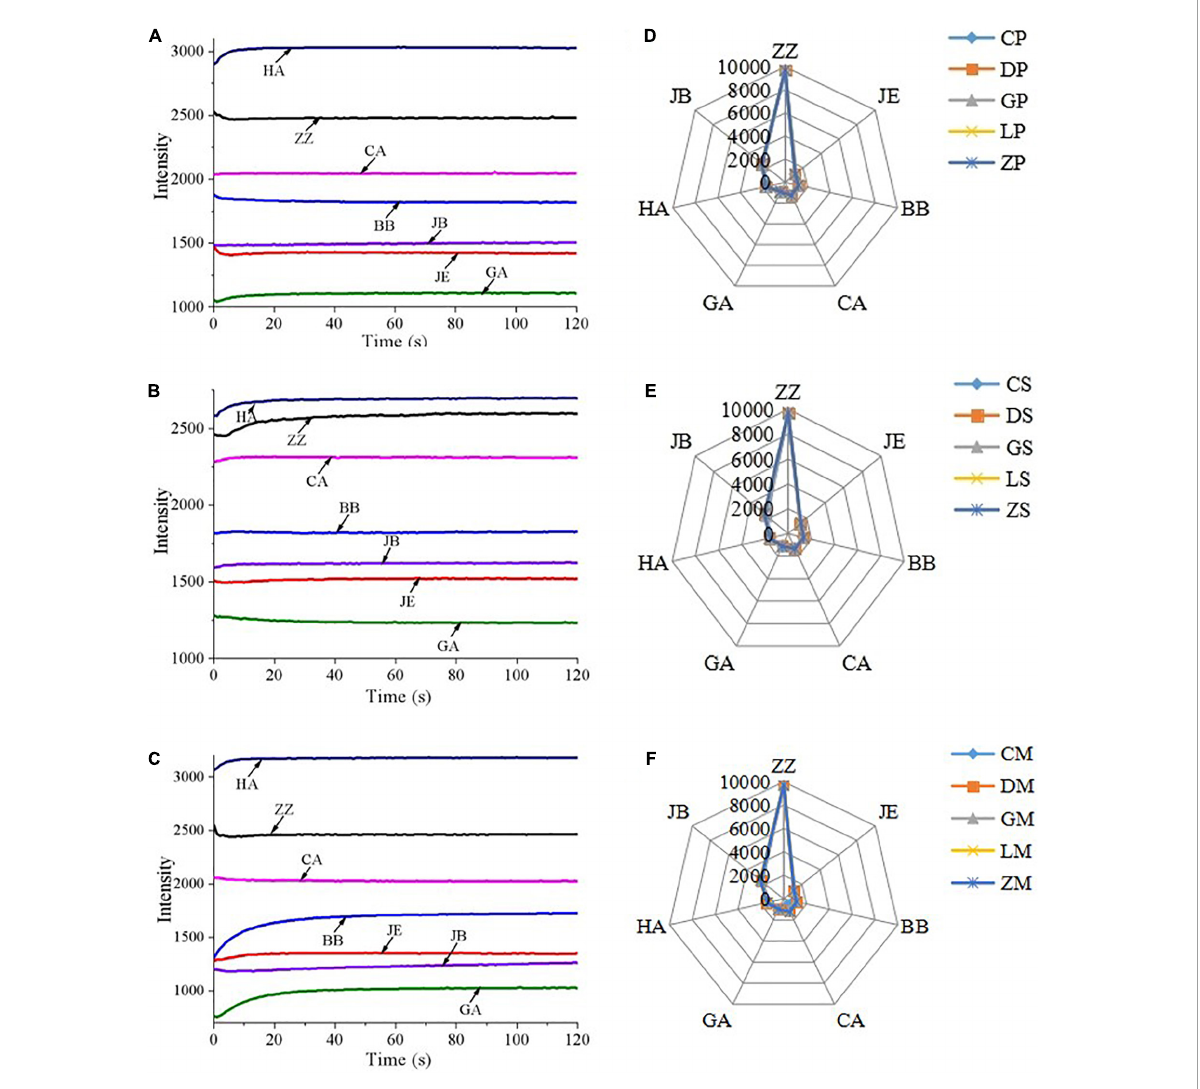
FIGURE2 E-tongue responses to instant starch noodles seasonings of CP (A) , CS (B) and CM (C) , and radar plots of 10 e-tongue sensor responses for seasoning powder (D) , seasoning mixture sauce (E) and the mixture of powder and sauce (F) . ZZ, JE, BB, CA, GA, HA, and JB are seven different liquid cross-selection sensors for the electronic